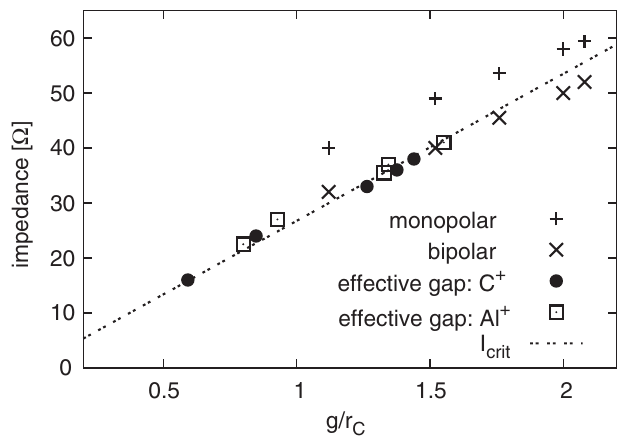
. C FIG. 7. Snapshots at 40 ns of kinetic ( (cid:5) 200 keV ) ion density for the SMP diode with an aspect ratio of (a) g=rC ¼ 1 : 76 and (b) g=rC ¼ 2 : 08 . Ions are drawn from an Al þ anode plasma which fills the space between the ions and the anode. Arrows indicate the approximate trajectory of ions drawn from the ’’ impedance is plasma. The density contours are plotted on a log crit 10 10 – 10 16 cm (cid:1) 3